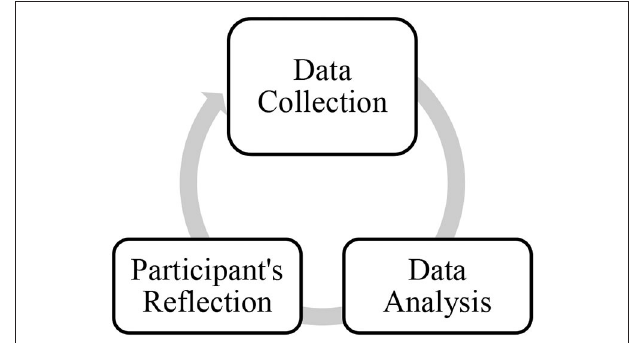
FIGURE 1 | The process of data collection and data